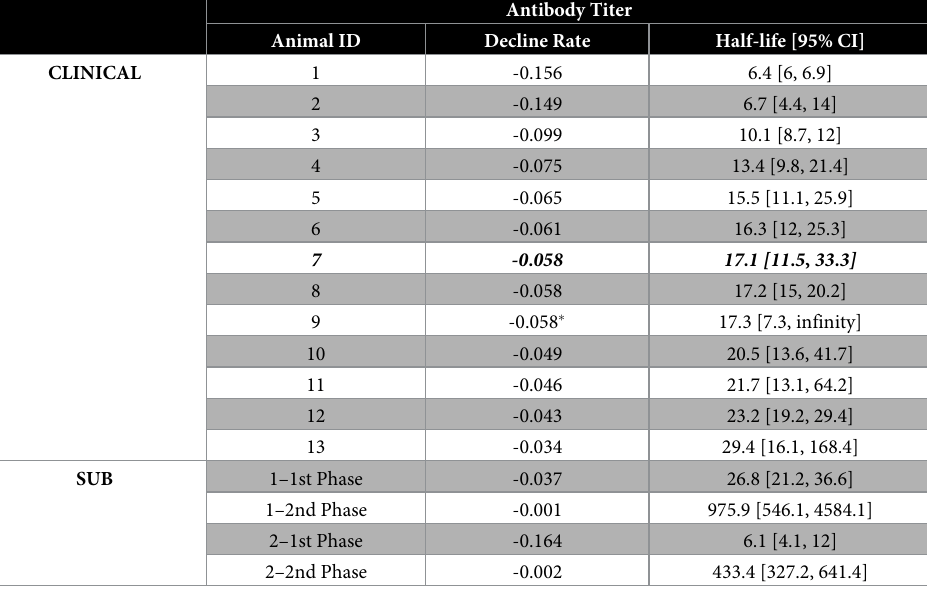
Table 3. Antibody titer decline rates and half-life values in days with their corresponding 95% confidence inter- vals [95% CI]. Data are reported for each individual in the CLINICAL and SUBCLINICAL datasets as well as for the first and second phase of titer decline observed for the SUBCLINICAL animals. Rates for the CLINICAL animals are ordered from high to low with the median decline and half-life values in bold italics . The titer decline rate marked with an asterisk ( � ) was not significantly different from